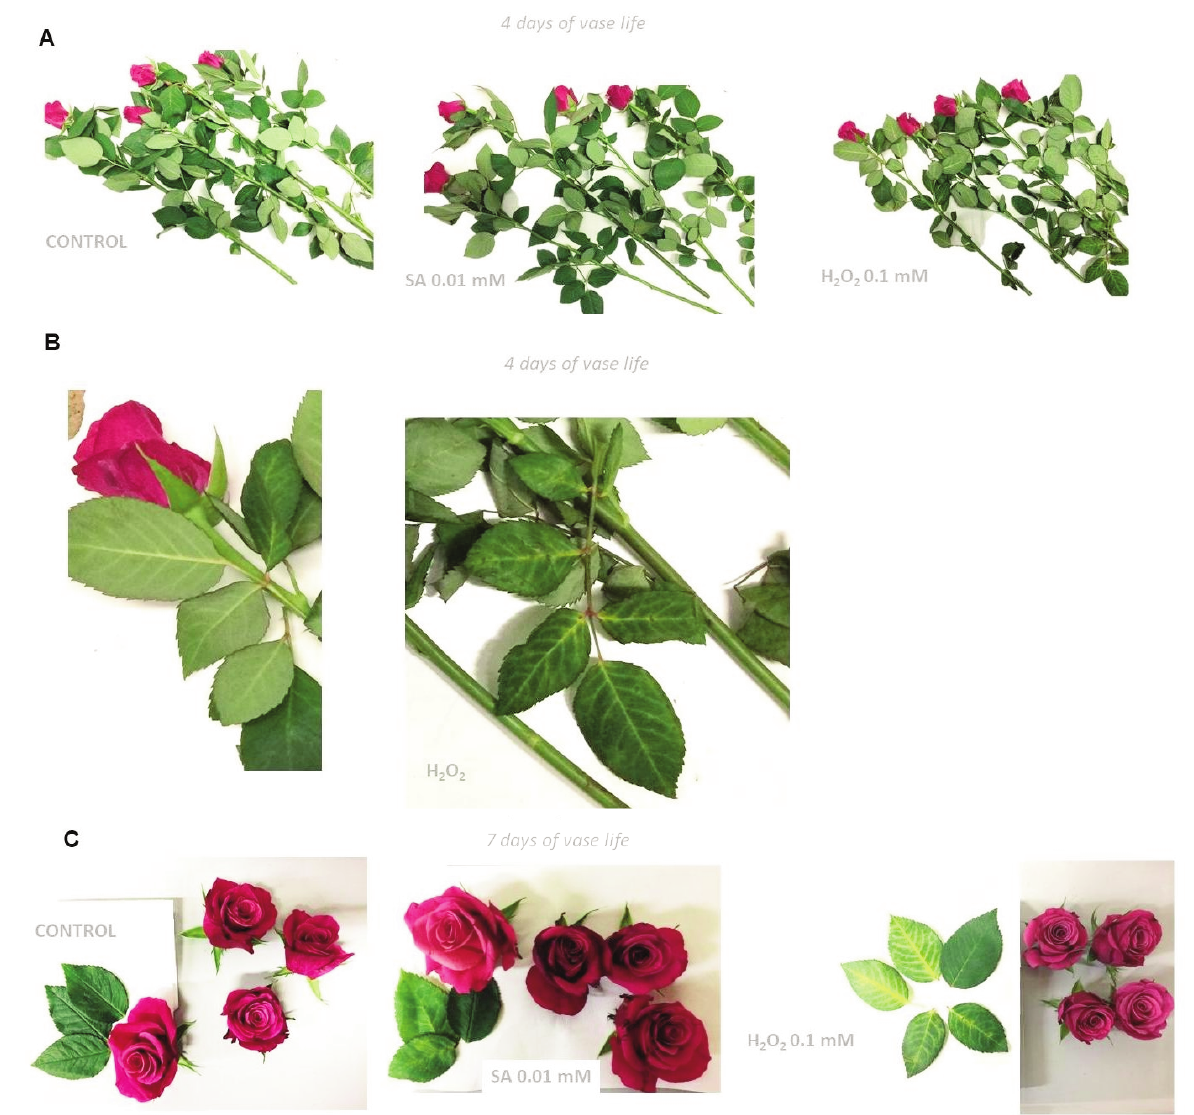
Fig. 2 - Visual appearance of cut roses (cv. Tacazzi) as affected by H